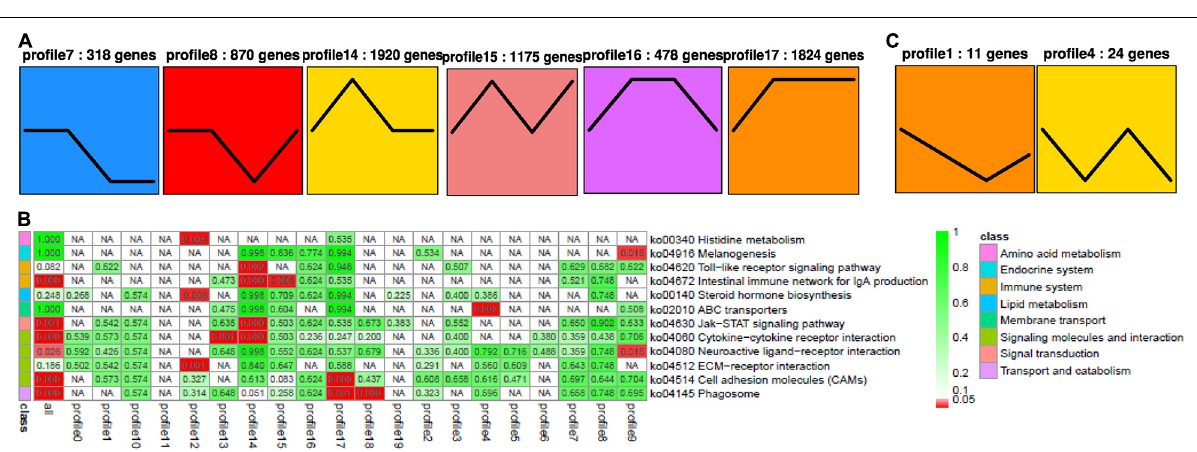
FIGURE 4 | STEM analysis of RNA (A) with its relevance (B) , and miRNA (C) . The ID of the trend and the number of genes in the trend are shown at the top of the figure; the trend block with color ( p < 0.05): the trend with significant enrichment and the trend block with a similar trend have the same color. In the pathway enrichment analysis p -value (Q-value) heat map, the filtering standard is less than or equal to 0.05 in at least one trend. The color bar legend “class” on the left represents the KEGG B class pathway annotation. Each row represents a KEGG pathway annotation, and each column represents a trend or all trends. The number in the grid is the p -value/Q-value; “NA” means that the pathway is not enriched in the trend. The darker the lattice color is, the more significant the pathway enrichment